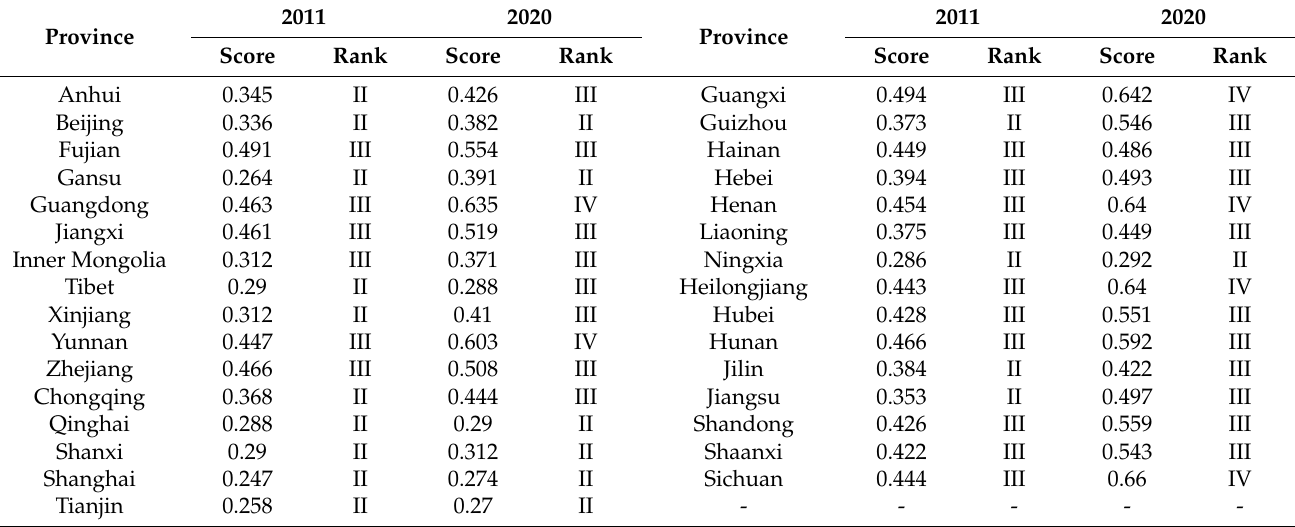
Table 2. Scores for China’s agricultural environment.